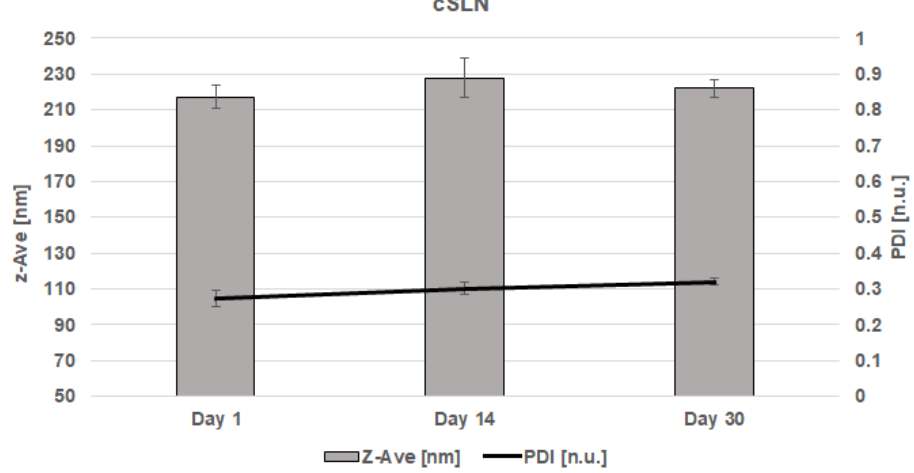
Figure 2. Z-Ave and PDI for CBD-cSLN on the 1, 14, and 30 days after the production. Zeta potential (ZP) of empty cSLN was − 18.09 ± 0.81 [mV], whereas of CBD-cSLN